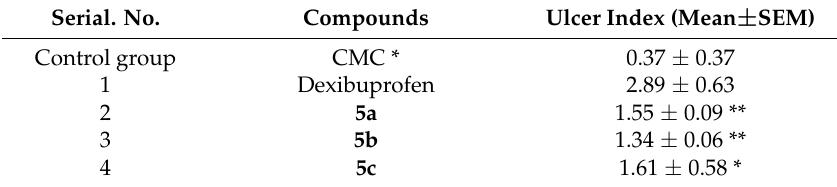
Table 5. Ulcerogenic activity of synthesized mutual prodrugs ( 5a – c ) and Dexibuprofen. Serial. No.